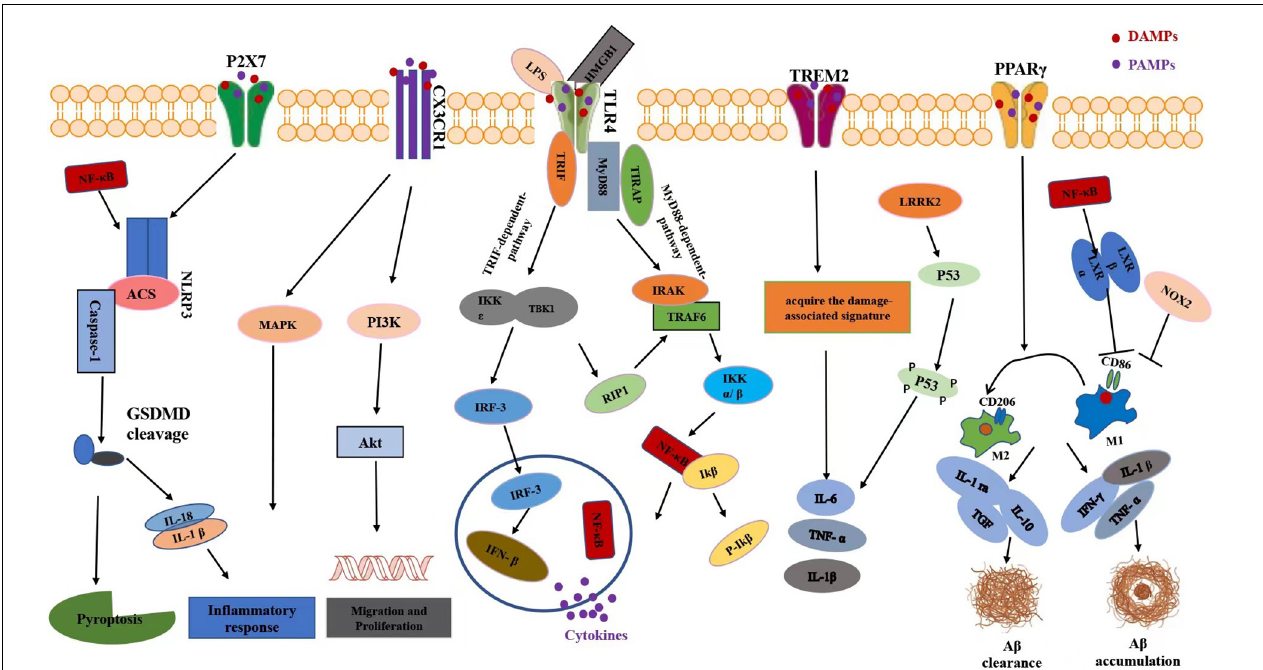
FIGURE 2 | Schematic diagram of microglia-mediated neuroinflammation signaling pathways after TBI. In response to TBI, DAMPs such as HMGB1 can promote priming of the NLRP3 inflammasome through NF- κ B signaling. In microglia, activation of P2X7 receptor could stimulate the NLRP3 inflammasome, which subsequently leads to the outflow of pro-inflammatory cytokines including IL-18 and IL-1 β . CX3CL1 is also known to induce microglia activation through intracellular phosphorylation of microglial p38 MAPK. Further, treatment of cultured microglia with CX3CL1 promoted cell survival and inhibited Fas ligand-induced cell death via the Akt signaling pathway. TLR signaling initiates acute inflammatory response by promoting the release of pro-inflammatory cytokines. Ligand binding to TLR4 activates either a MyD88-dependent NF- κ B activation or MyD88-independent activation of interferon regulatory factor-3 (IRF-3) activation and the subsequent expression of IFN β . The TREM2 pathway is responsible for switching from a homeostatic to a neurodegenerative microglial phenotype after phagocytosis of apoptotic neurons. Upon activation, the PPARs regulate inflammation via trans-reexpression of multiple inflammatory signaling systems such as NF κ B, activator protein-1 (AP-1), signal transducer and activator of transcription (STAT) to result in M1/M2 microglia polarization and facilitate it toward an anti-inflammatory state. In LPS induced neuroinflammation, LRRK2 could phosphorylate p53 and promote the production of pro-inflammatory cytokine such as tumor necrosis factor (TNF)- α . Activation of NOX2 aggravated inflammatory-mediated neurodegeneration after TBI via inhibiting switch from M1-like activation to M2- like activation of microglia. Pro-inflammatory cytokines expressed by microglia, including interferon- γ , interleukin-1 β , and tumor necrosis factor- α , can specifically stimulate A β accumulation while anti-inflammatory cytokines such as IL-1ra, IL-10, and TGF preclude formation of A β . HMGB1, high mobility group box 1; N-F κ B, nuclear factor-kappa B; MAPK, mitogen-activated protein kinase; PI3K, phosphoinositide 3-kinase; IFN- β , IRF-3-inducing interferon-b. TREM2, triggering receptor expressed on myeloid cells 2. LRRK2, leucine-rich repeat kinase 2; LPS, lipopolysaccharide; PPAR γ , peroxisome proliferator-activated receptor gamma. IL-1ra, interleukin-1 receptor antagonist; A β , beta